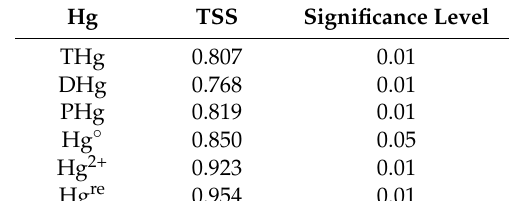
Table 6. Pearson correlation coefficients of different Hg species and total suspended solid (TSS).